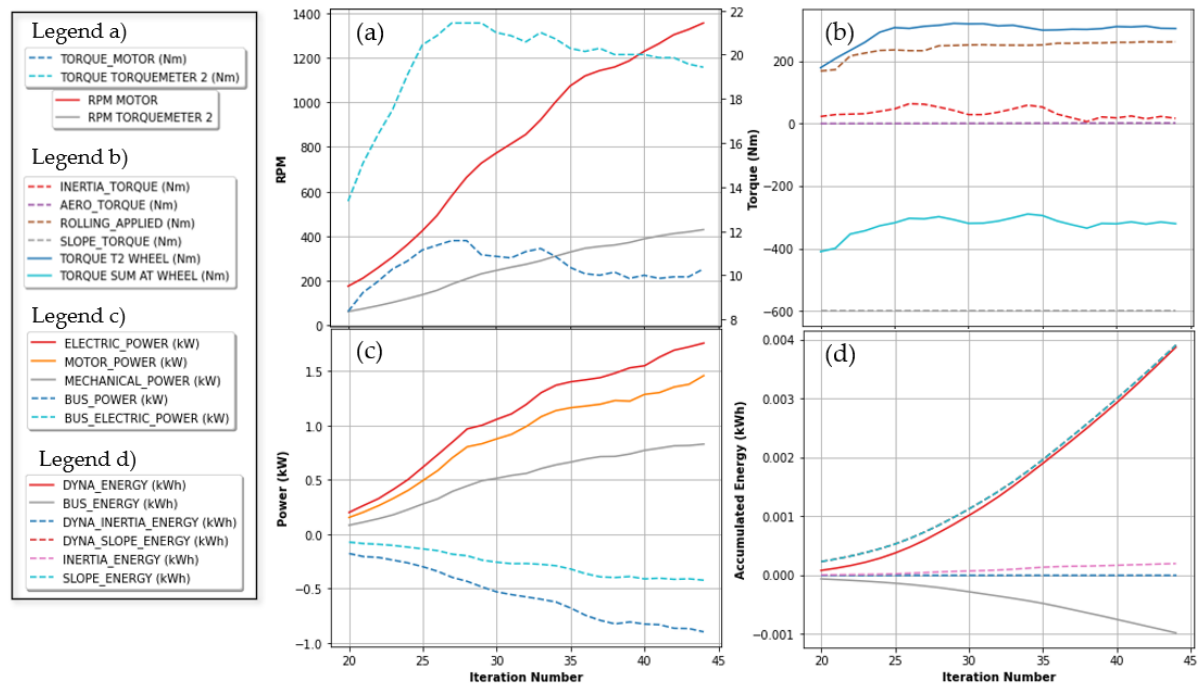
Figure 13. Accelerating downhill stretch with constant slope. ( a ) Torques and RPMs measured by dynamometer sensors. ( b ) Torques values per origin force. ( c ) Dynamometer power and equivalent bus power. ( d ) Accumulated energy for the whole route.